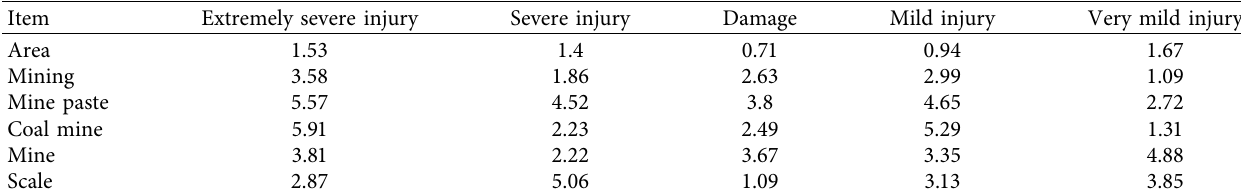
Table 3: Failure characteristics of the staggered joint structure of GIL integrated pipe